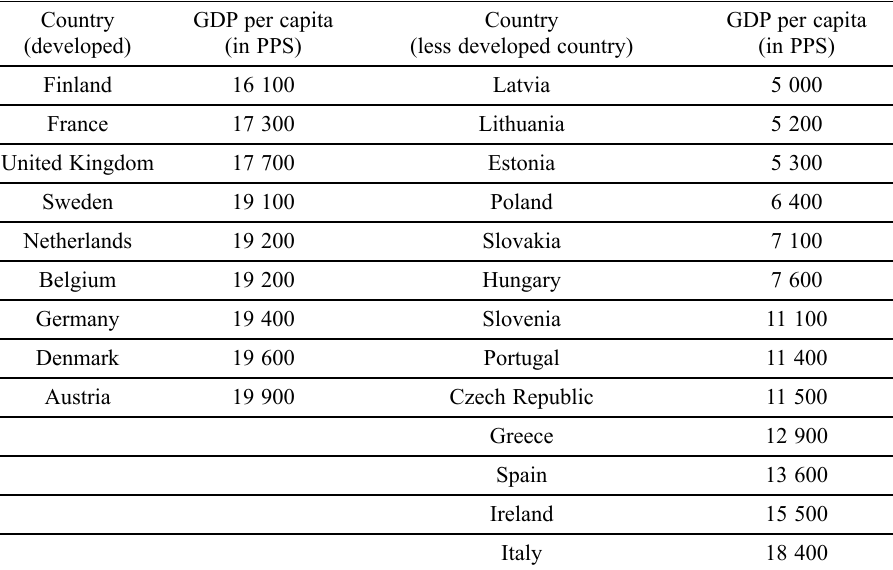
Table 3. Country groups and GDP per capita (in